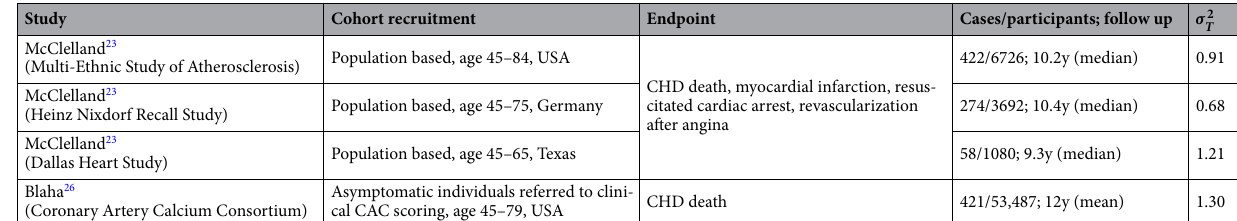
Table 1. Studies investigating the incremental prognostic value of coronary artery calcium (CAC) scoring. Studies and estimated variances of the log risks predicted by traditional risk factors ( σ 2 variance by CAC scoring ( σ CAC ). For all studies, traditional risk factors include age, sex, smoking, systolic blood pressure, anti-hypertensive medication, total cholesterol, high-density lipoprotein cholesterol, lipid- lowering medication, diabetes, family history, and ethnicity. CHD Coronary heart disease.